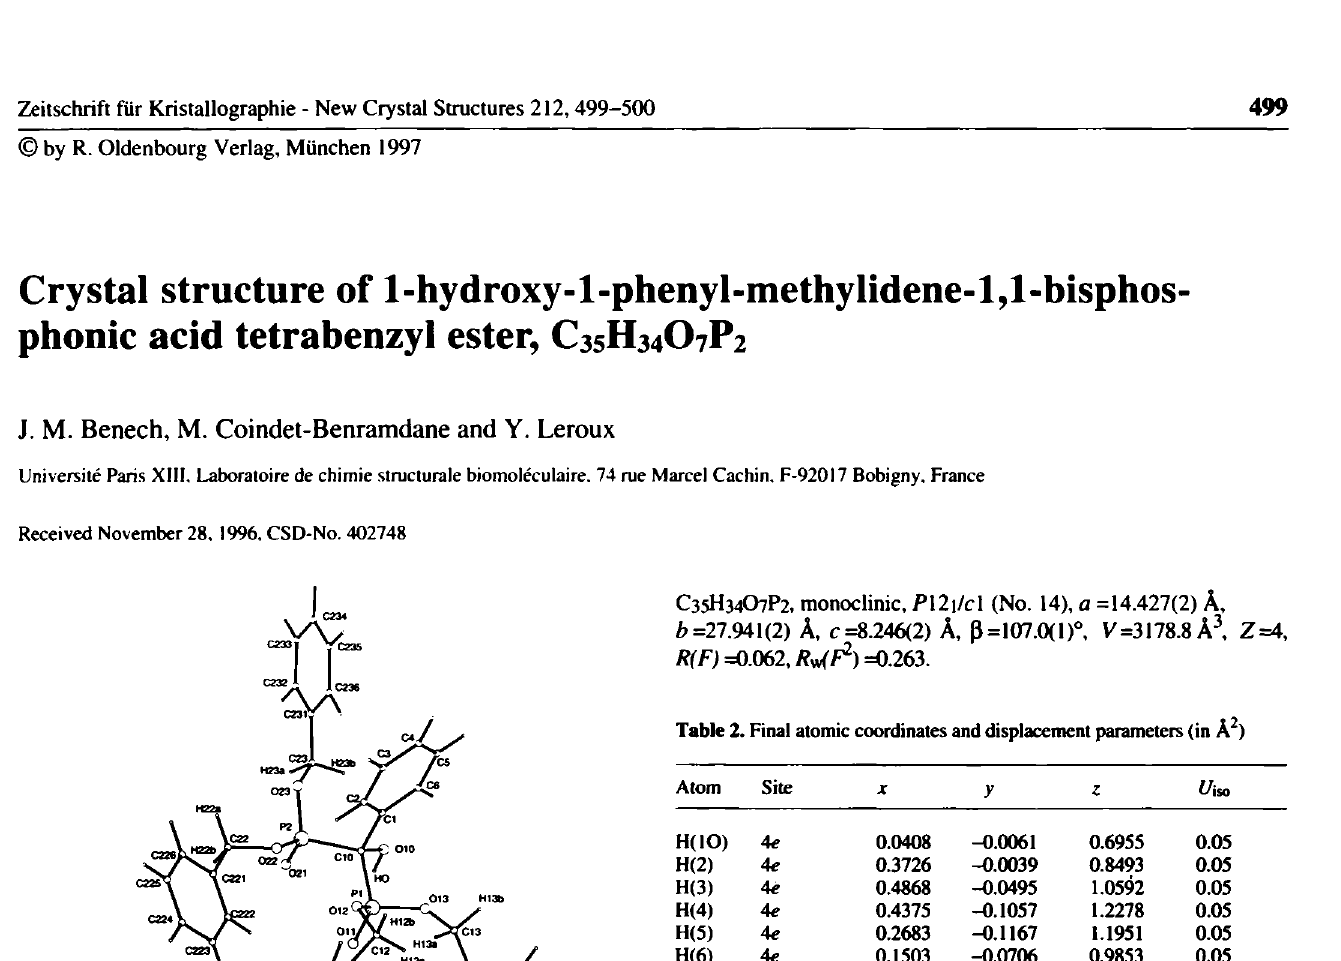
Table 2. Final atomic coordinates and displacement parameters (in Â 2 )